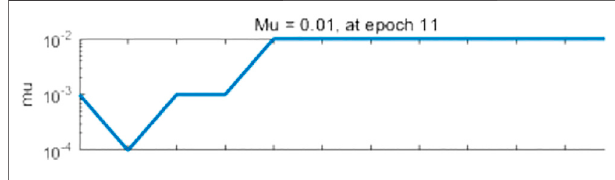
FIGURE 3 | Mu value of FA-NAR network training.